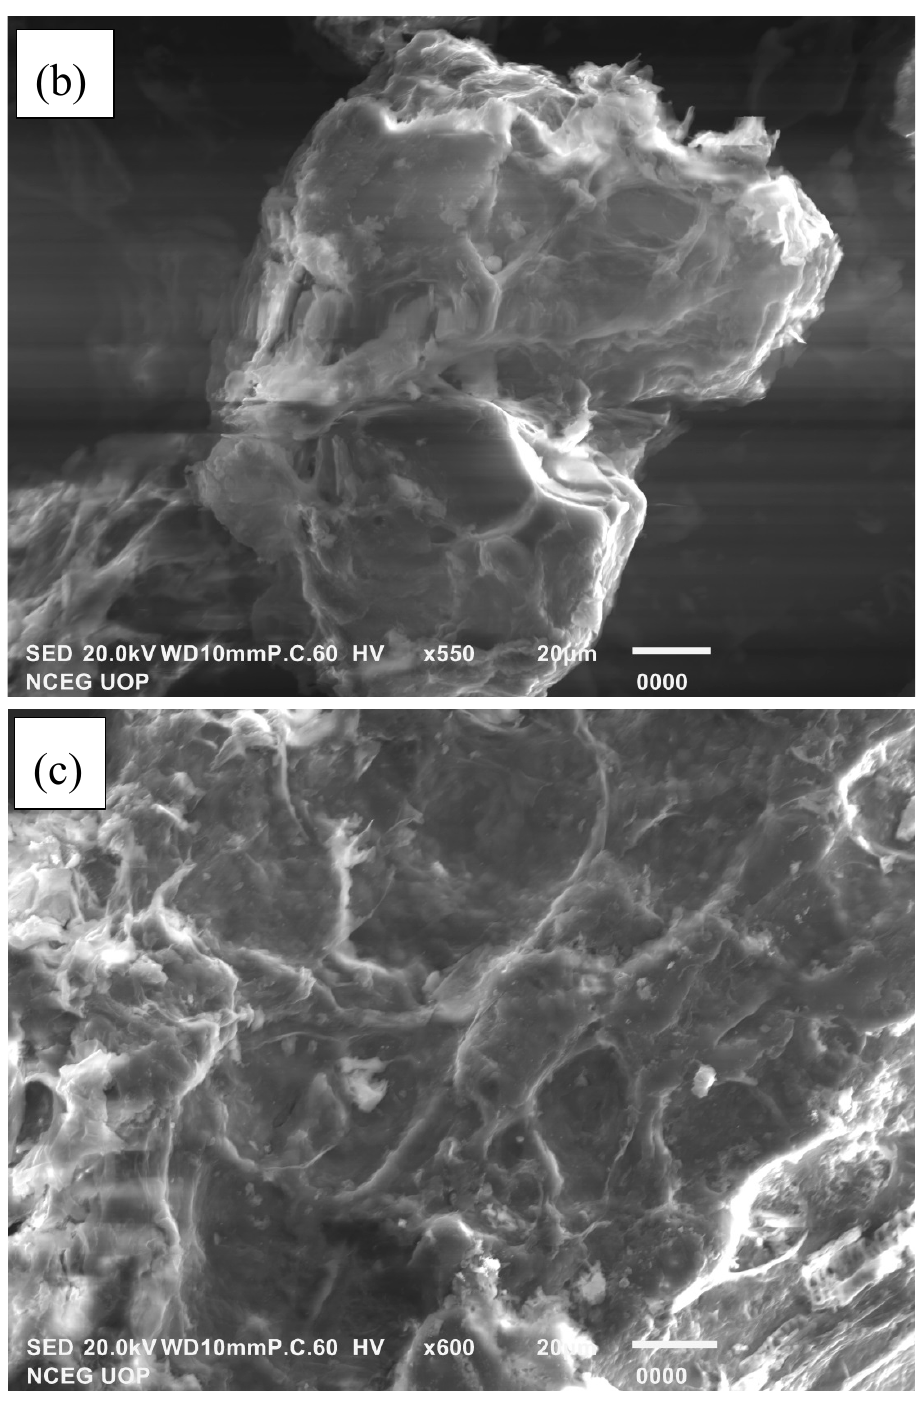
Figure 5. SEM of ( a ) raw pomegranate peels; ( b ) acid-washed; ( c ) impregnated sample.